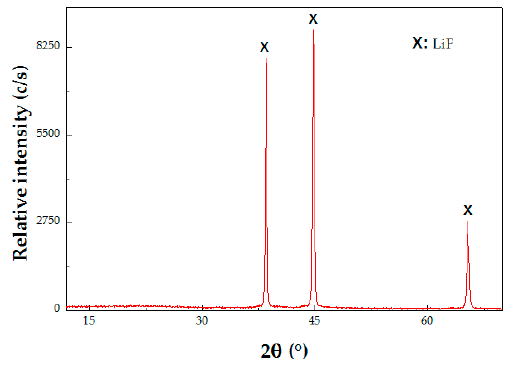
Figure 11. XRD of the precipitated solid by evaporation.